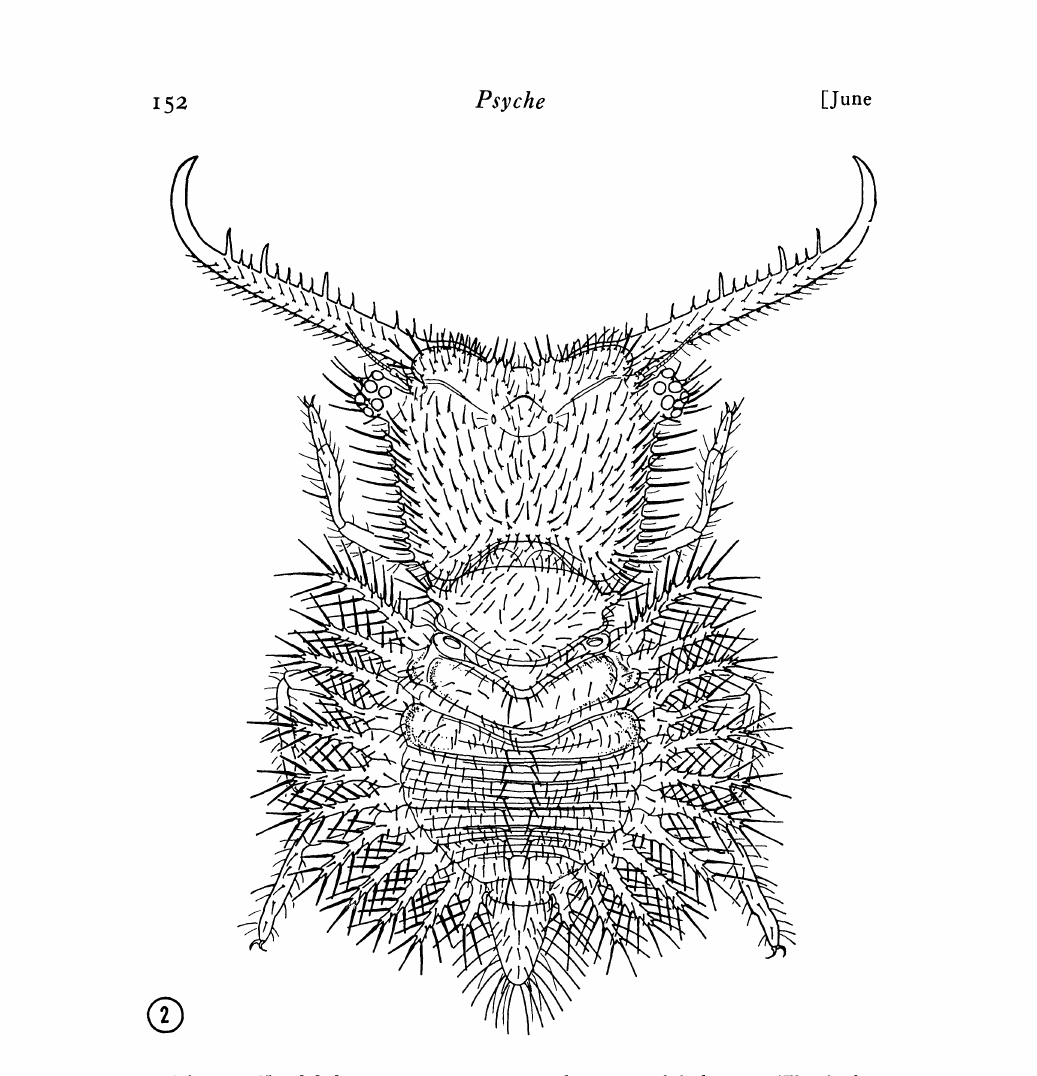
Fig. 2. Neadelphus protae n. sp. Dorsal aspect of holotype. The body, which is slightly curved in the specimen, is here depicted as straightened